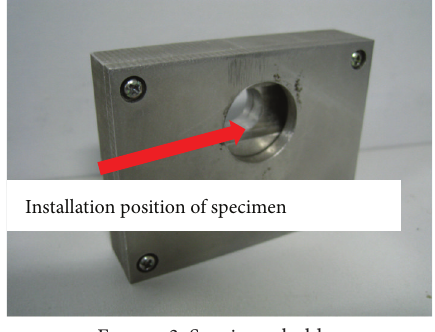
Figure 3: Specimen holder.